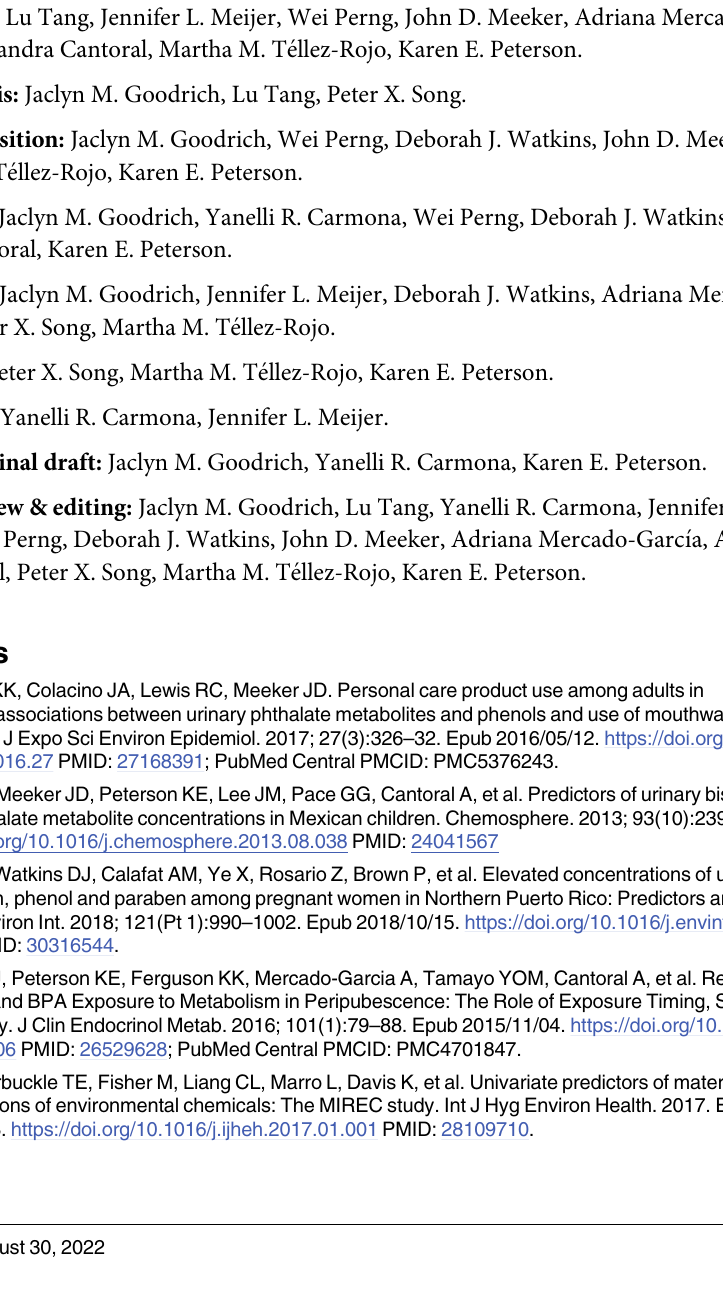
S2 Table. Number of associations with q < 0.1 between all exposure measures and 572 metabolites among